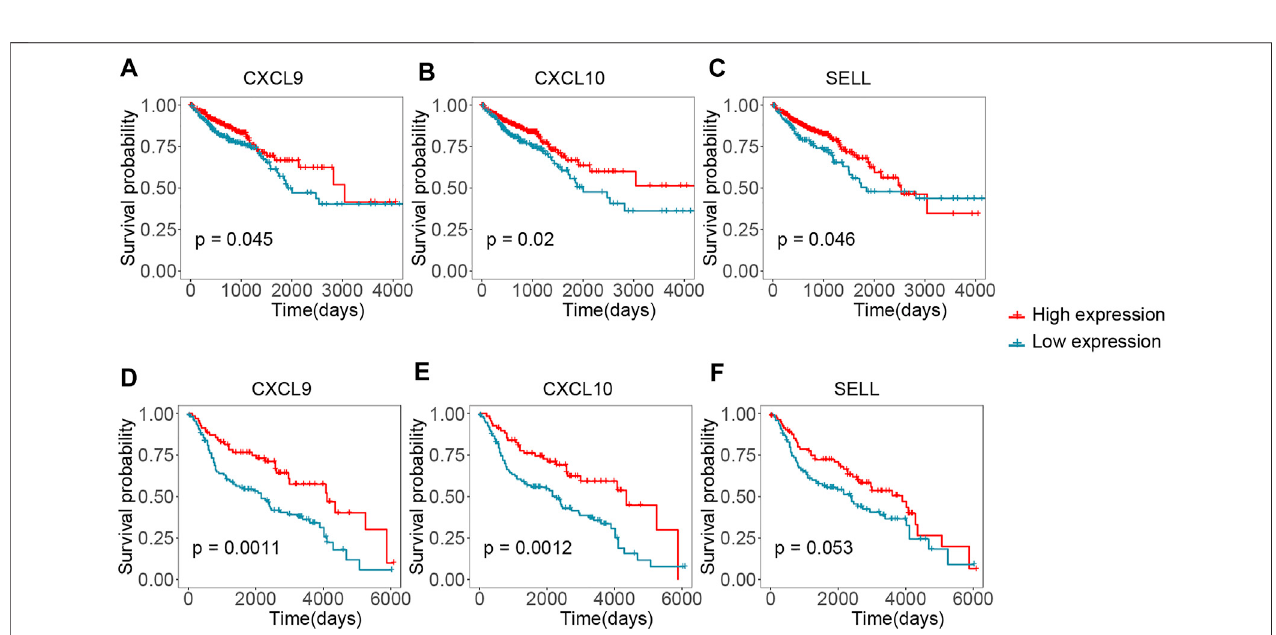
FIGURE 6 | Validating the hub genes by survival time in TCGA and GEO cohorts. (A – C) Kaplan-Meier plots re fl ecting the overall survival status of CRC patients in TCGA cohort. (D-F) Kaplan-Meier plots showing the overall survival status of CRC patients in GSE41258 cohort.